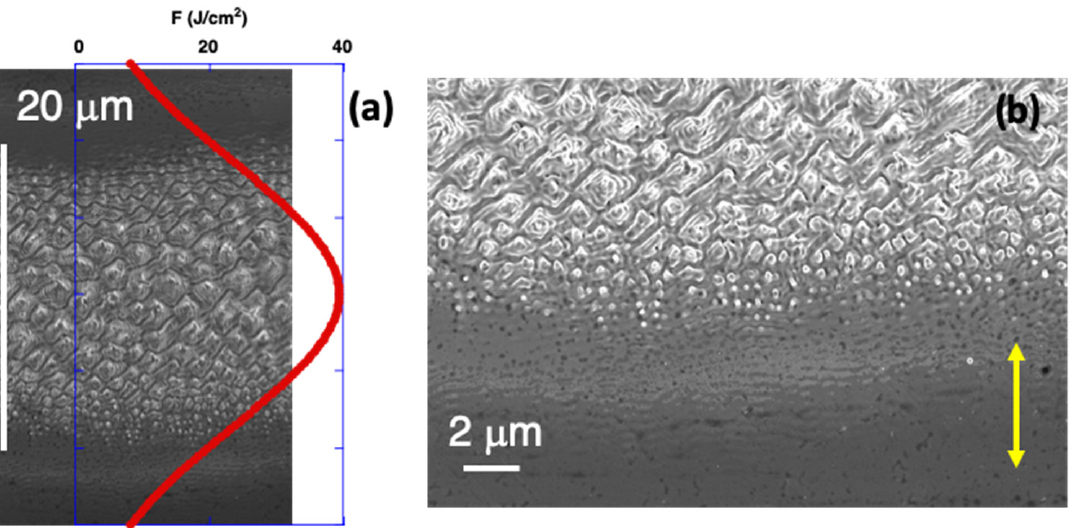
Figure 5. ( a ) Top-view SEM (in-lens) micrograph on the spatial evolution of various nanostructures and microstructures generated on Ni5W tape in a horizontal laser processed line, due to the Gaussian fluence distribution ( F , red curve). Laser processing parameters were: F av = 135.6 mJ/cm 2 , v L = 100 mm/s, f rep = 800 kHz and < F 1D > = 29.0 J/cm 2 . ( b ) Details of the lower part of the laser processed line. The vertical yellow double-arrow indicates the laser beam polarization direction.